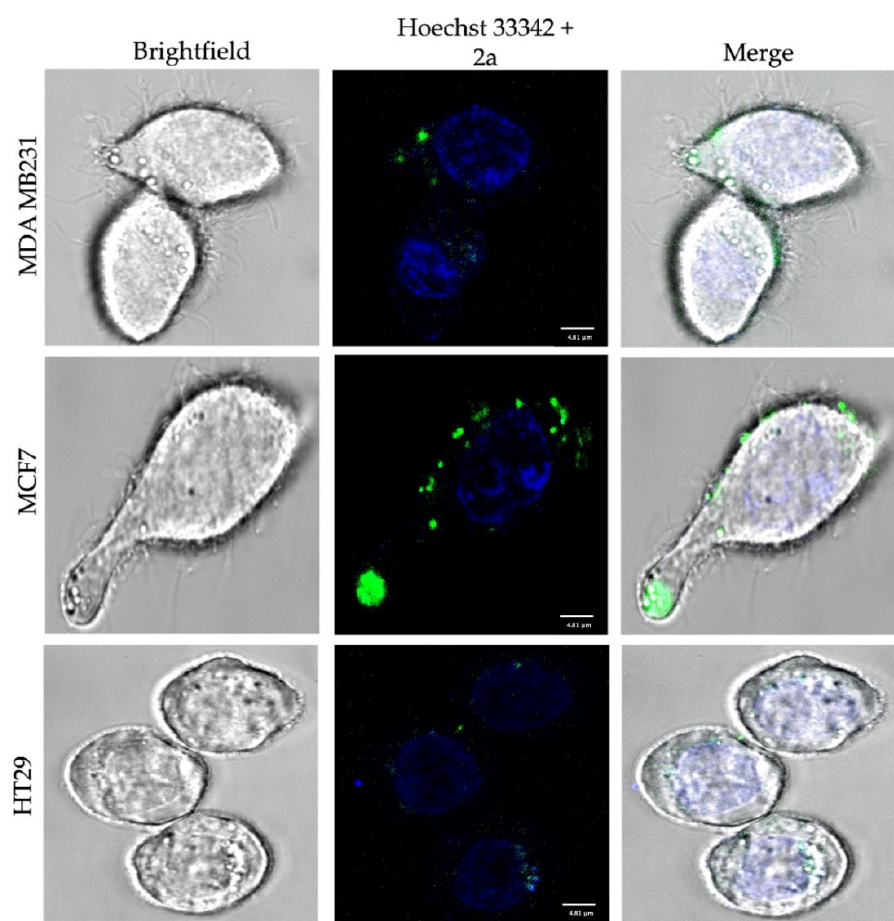
Figure 2. Confocal fluorescence microscopy images of compound 2a (10 μ M, λ exc = 488 nm, λ em = 550–680 nm) in MDA-MB-231 and MCF7 (breast cancer cells) as well as HT29 (colorectal carcinoma cells). Cells were counterstained with Hoechst 33342 for nuclear labelling. Scale bar: 5 μ m.